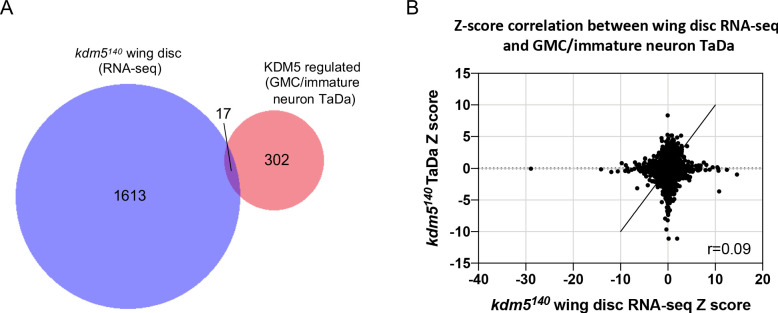
Transcriptome analyses reveal that lysine demethylase 5 (KDM5)-regulated gene expression is tissue-specific.(A) Venn diagram illustrating intersection of kdm5140 and kdm5 shRNA overlapping targeted DamID (TaDa) data with that from a previously published kdm5140 mRNA-seq wing disc dataset (Drelon et al., 2018). (B) Correlation of Z scores between kdm5140 TaDa and kdm5140 wing disc mRNA-seq (Drelon et al., 2018) datasets. Pearson’s R = 0.09.